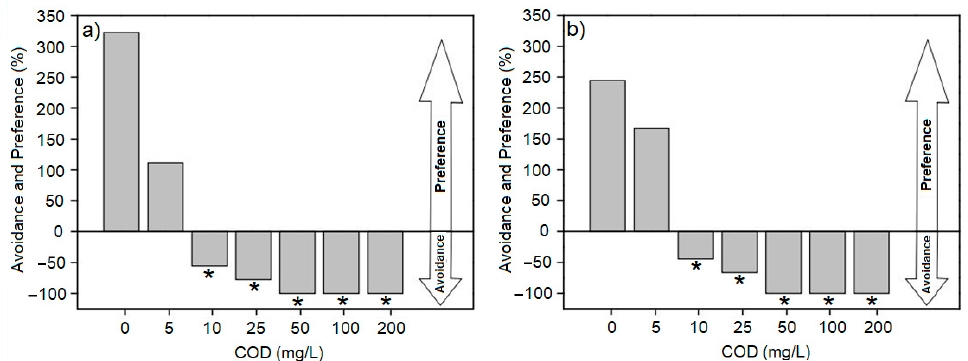
Figure 3. Preference and avoidance responses (%) of zebrafish exposed to dilutions of untreated synthetic water from the cassava starch industry: ( a ) after 4 h of exposition, and ( b ) after 6 h of exposition. Data were pooled from 3 replicates; therefore, the standard deviation is not presented. Asterisks represent statistically significant differences ( p < 0.05) in the distribution of organisms when compared with the distribution in control (Fisher’s exact test (2 × 2); see Tables S7 and S8 in Supplementary Material).